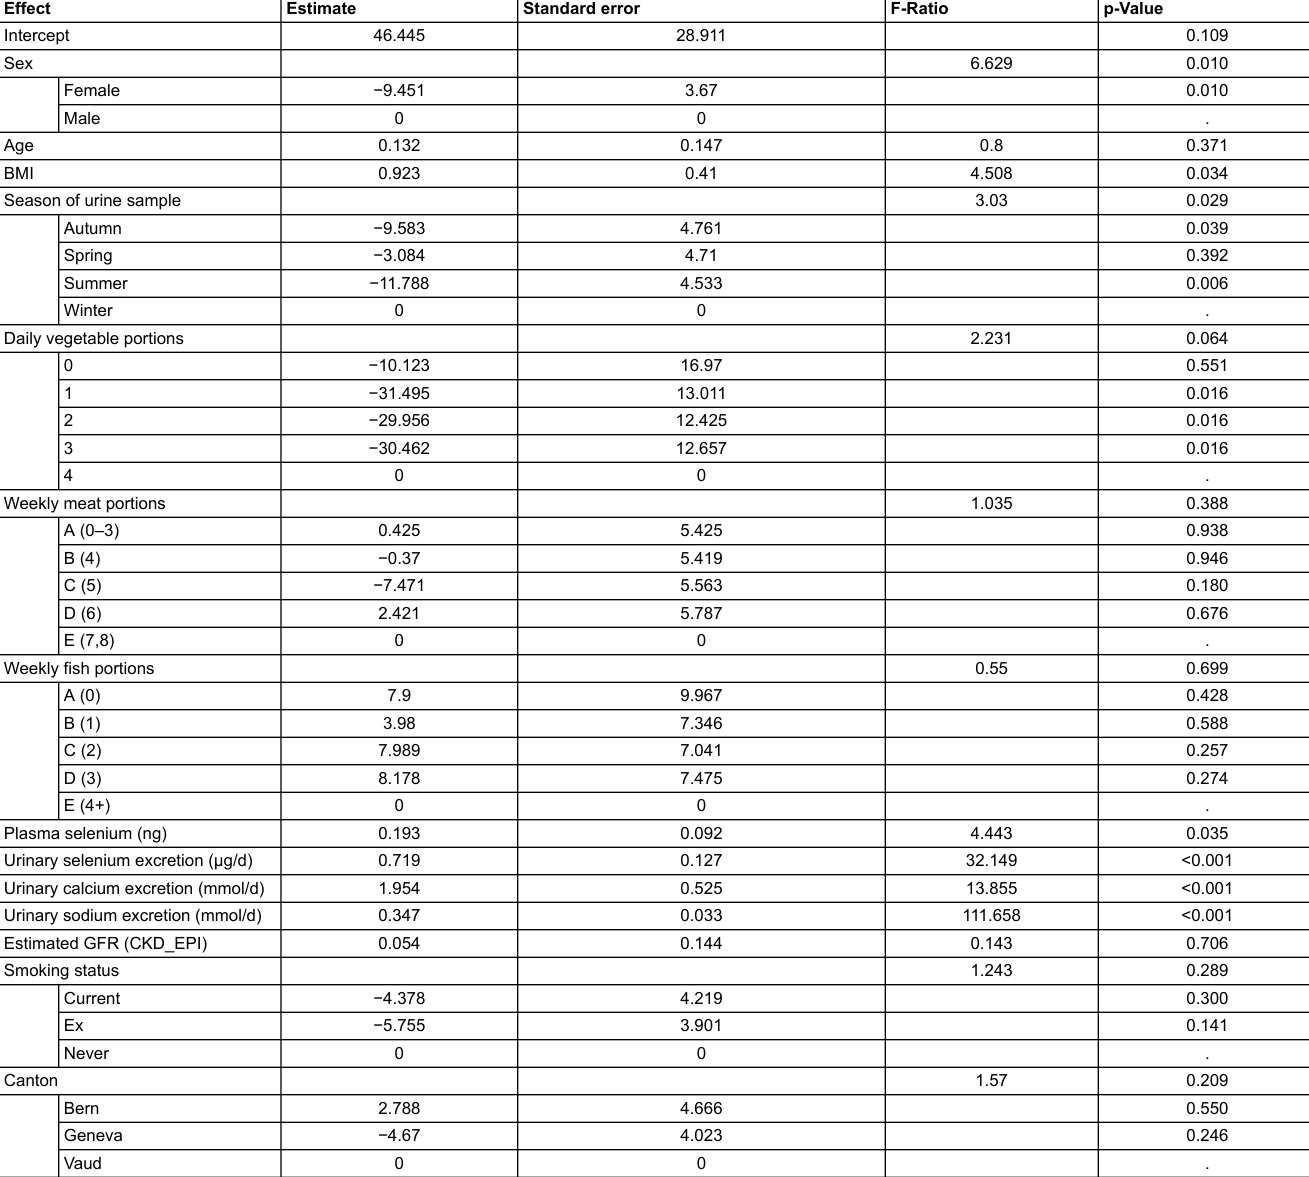
Table 2: Parameter estimates of the best model (LMM, fixed effects) describing the variables that influence the urinary iodine excretion, (a proxy for intake, related by a factor of 0.92).